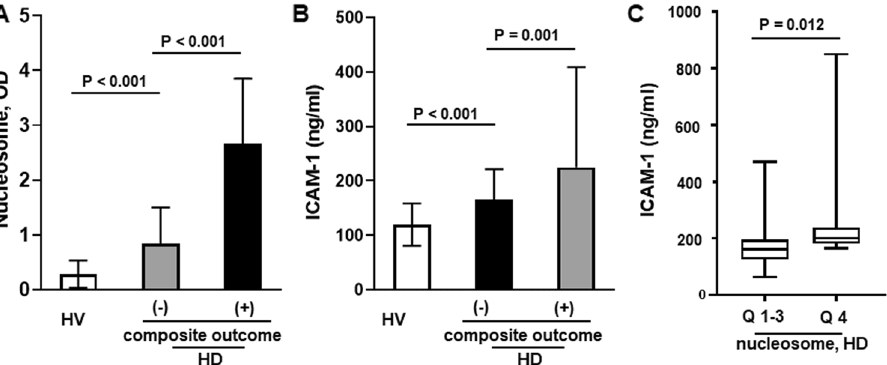
Figure 1. ( A , B ) Mean plasma levels of nucleosome and ICAM-1 in HVs, HD patients with the composite outcome, and HD patients without the composite outcome, and the between-group differences. ( C ) Mean